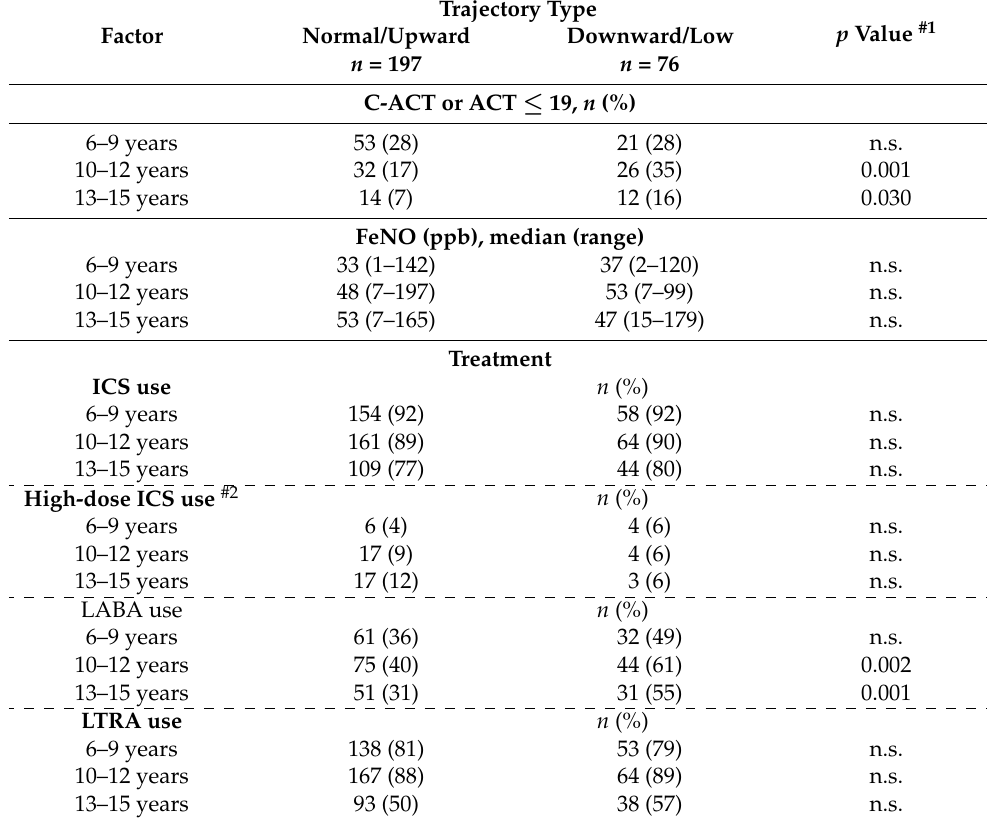
Table 3. Comparison of asthma control level, FeNO, and treatment between favorable and unfavor- able lung function trajectory groups.